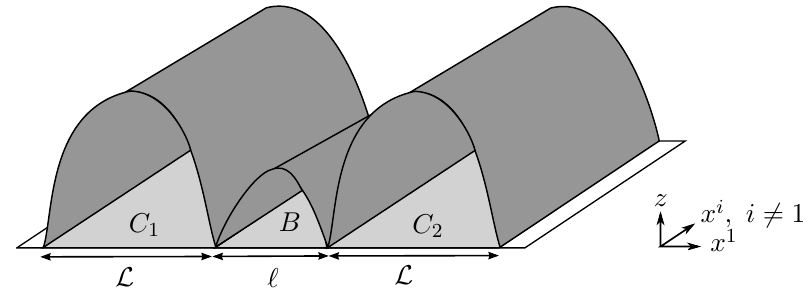
Figure 11. Construction for entanglement